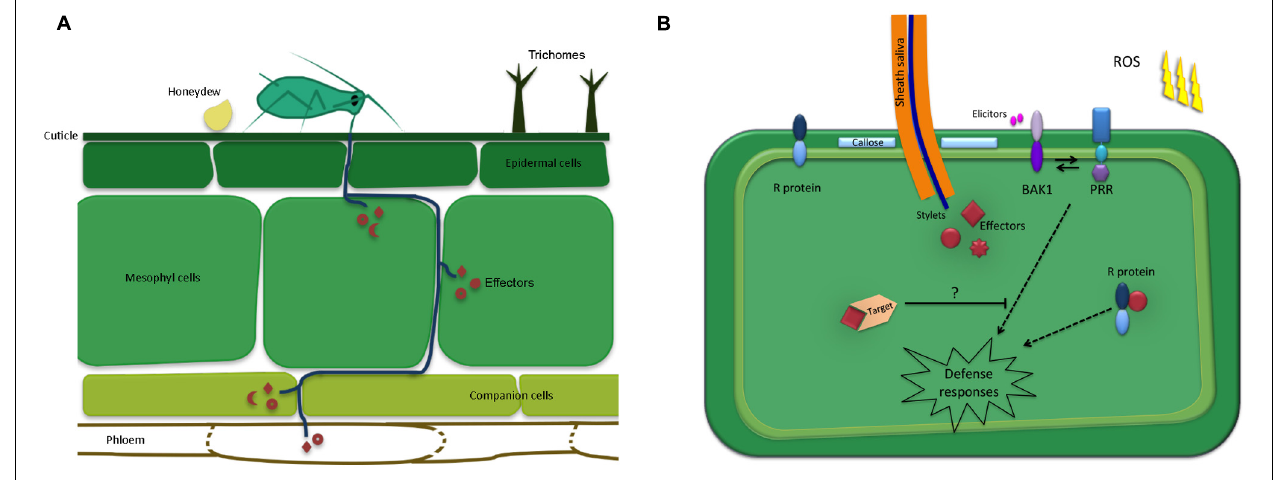
probing, aphids secrete effectors inside the host cell cytoplasm, which interact with targets to modulate host cell processes. In resistant plants, these effectors may be recognized by resistance (R) proteins leading to effector-triggered immunity. In addition, the plant may perceive conserved aphid-derived molecules, or elicitors, by means of pattern recognition receptors (PRRs).This perception involves BAK1, which is known to interact with identified PRRs to induce defense responses, including callose formation and the production of reactive oxygen species (ROS)